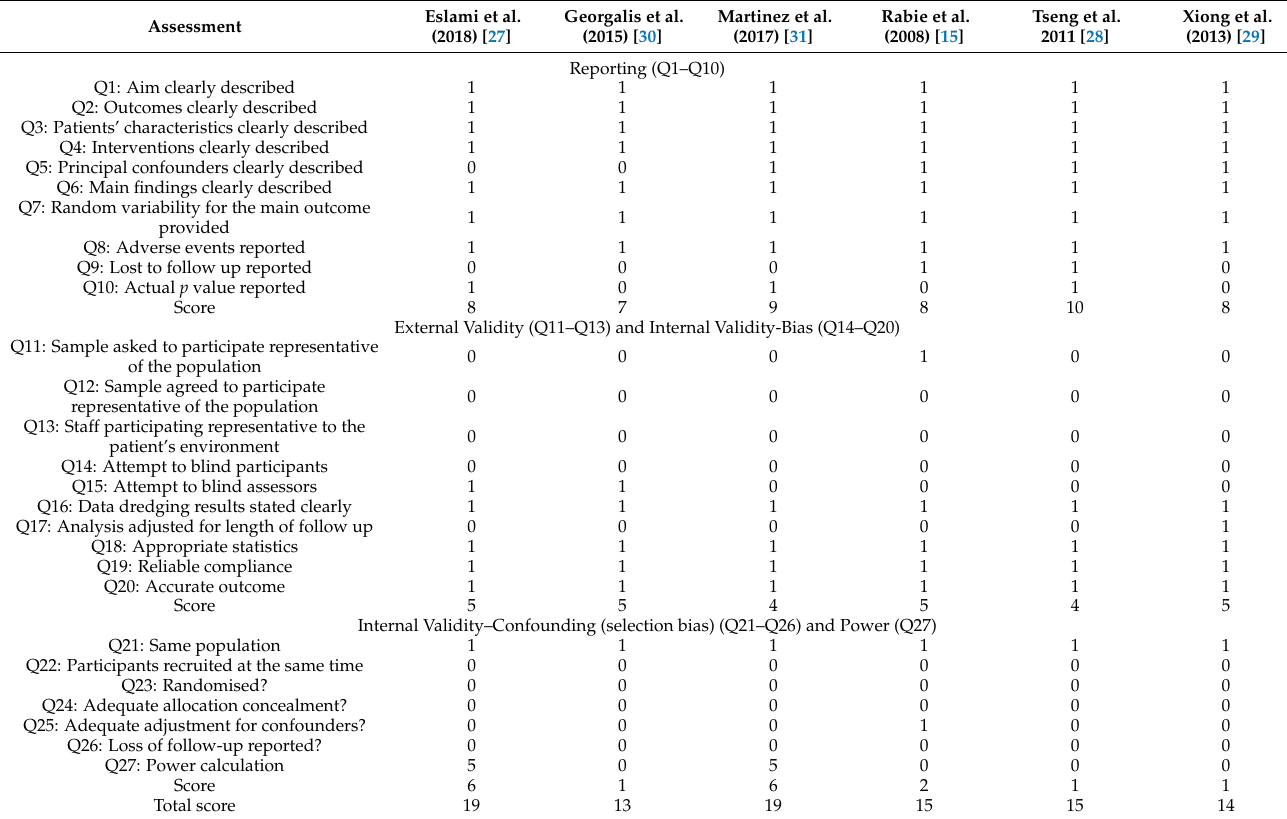
Table 3. Modified Downs and Black bias